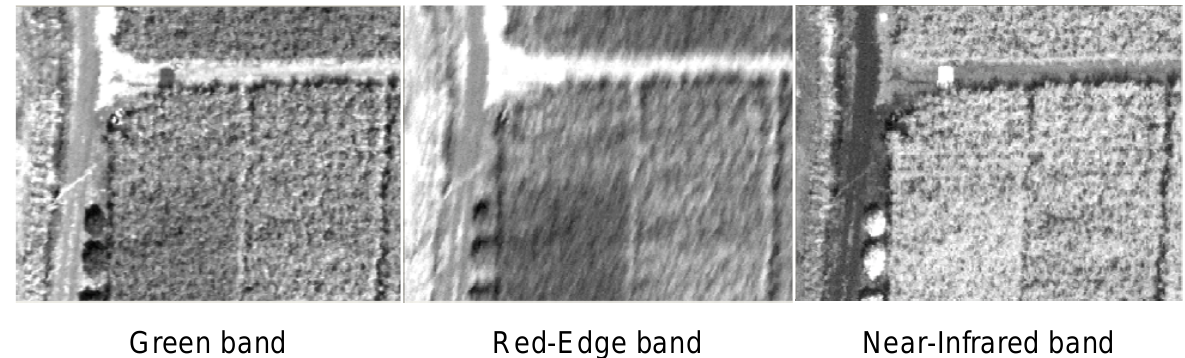
Green band Red-Edge band Near-Infrared